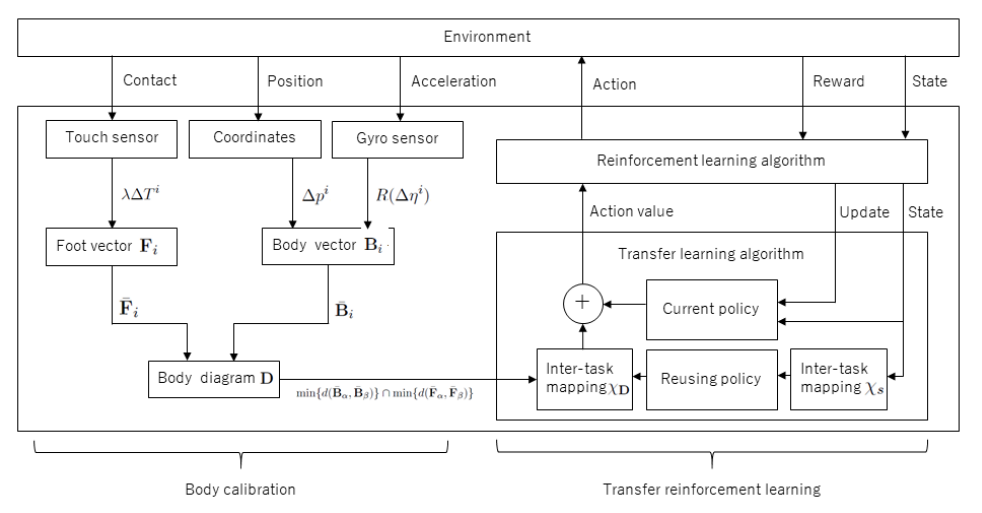
Figure 1. Simplified illustration of proposed method. The right side explains traditional transfer reinforcement learning, and the left side explains body calibration’s information